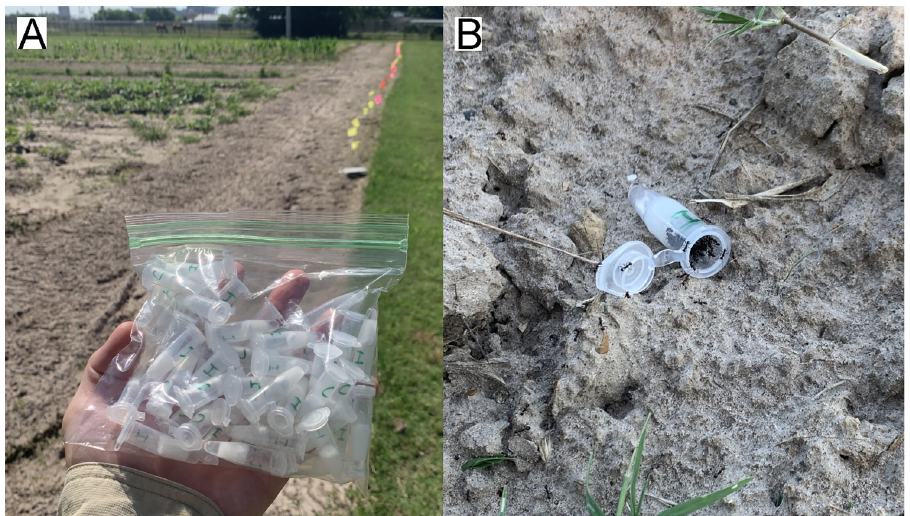
Fig 3. Ant recruitment in the field. (A) Bag of 50 mock EF nectar tubes, 25 mimicking the constitutive composition, labeled with a “C”, and 25 mimicking the induced composition, labeled with an “I”. Colored flags in the background mark the fifty 1 m sections that comprise a transect. The tubes were mixed in the bag and randomly selected for placement along the transect, on the ground to the left of the flags. (B) Close-up of a tube after 1 hr. In this case, a relatively large number of Pheidole obscurithorax were